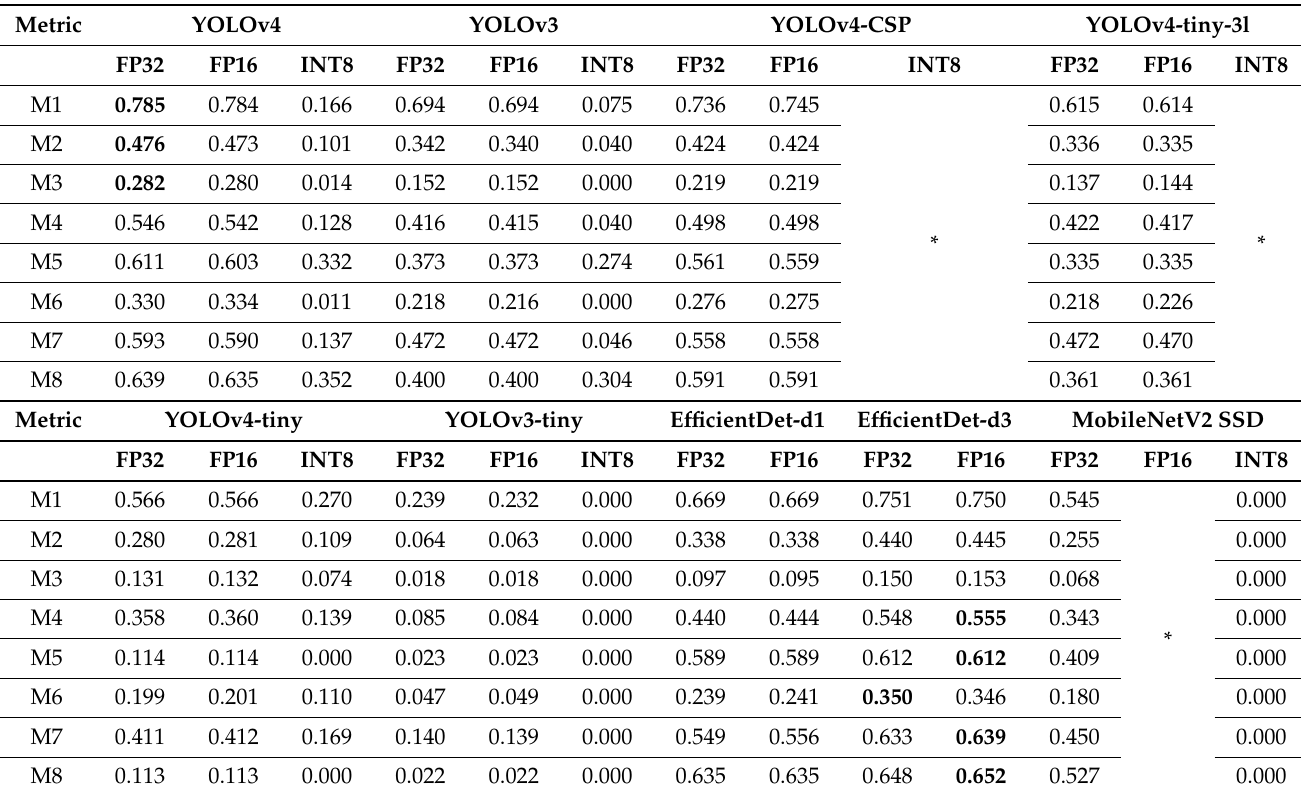
Table 2. Accuracy results for the tested models and their variants with a range of numerical representations. Explanations on the meaning of M1-M8 metrics are given in text. Asterisk (*) in a column means that the model could not be compiled for the given combination of computational platform and data representation